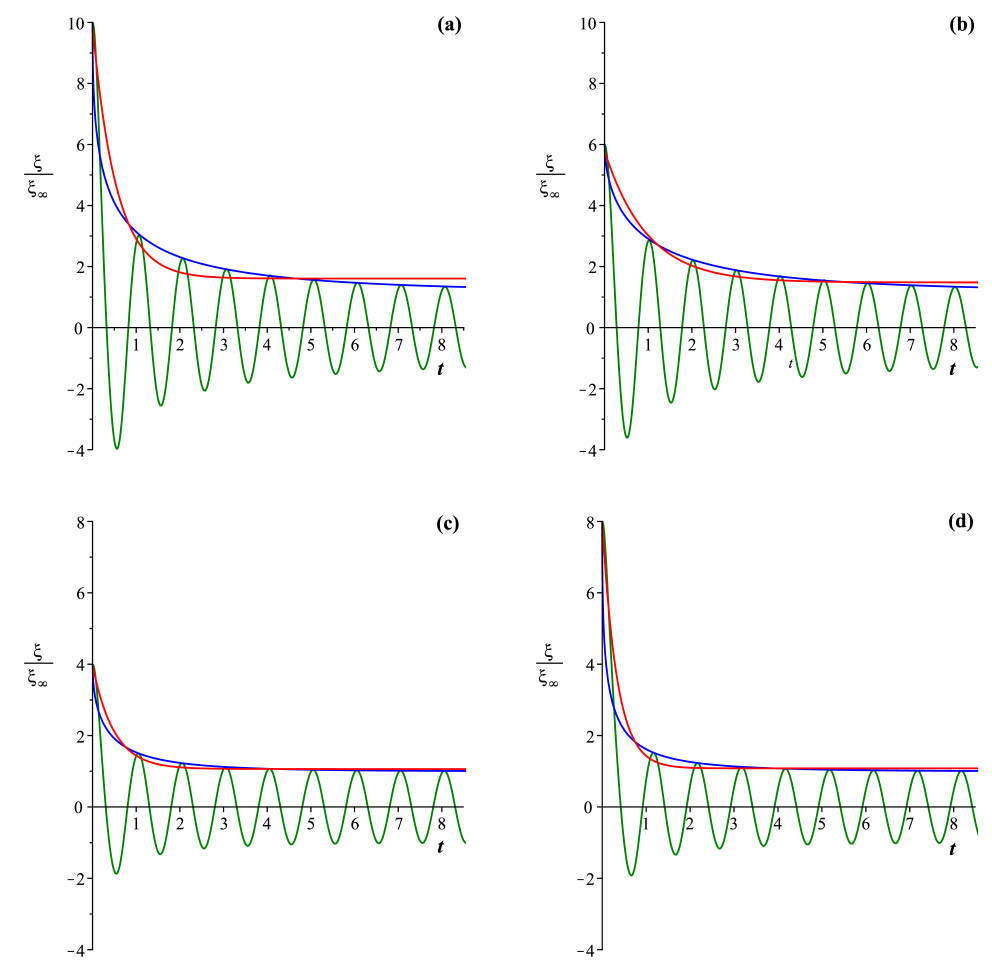
Figure 1. Evolution of an impulsively excited self-oscillation with the initial amplitude exceeding the stationary amplitude (green). The red and blue curves show the exponential and super-exponential fittings for the oscillation envelope, respectively. The oscillation amplitude is normalised to the stationary amplitude. The time is measured in oscillation periods, i.e., 2 π Ω and Ω K = 2 π . Panel ( a ): δ − δ v = − 0.1, and ξ 0 / ξ ∞ = 10. Panel ( b ): δ − δ v = − 0.1, and ξ 0 / ξ ∞ = 6 .